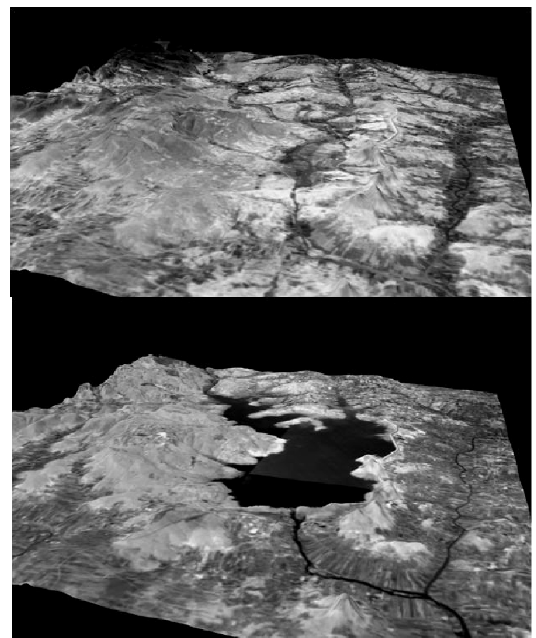
Figure 8. Perspective view of Hidkal dam area in 1973 (Hex agon-top) and 2011 (Cartosat-1- bo ttom